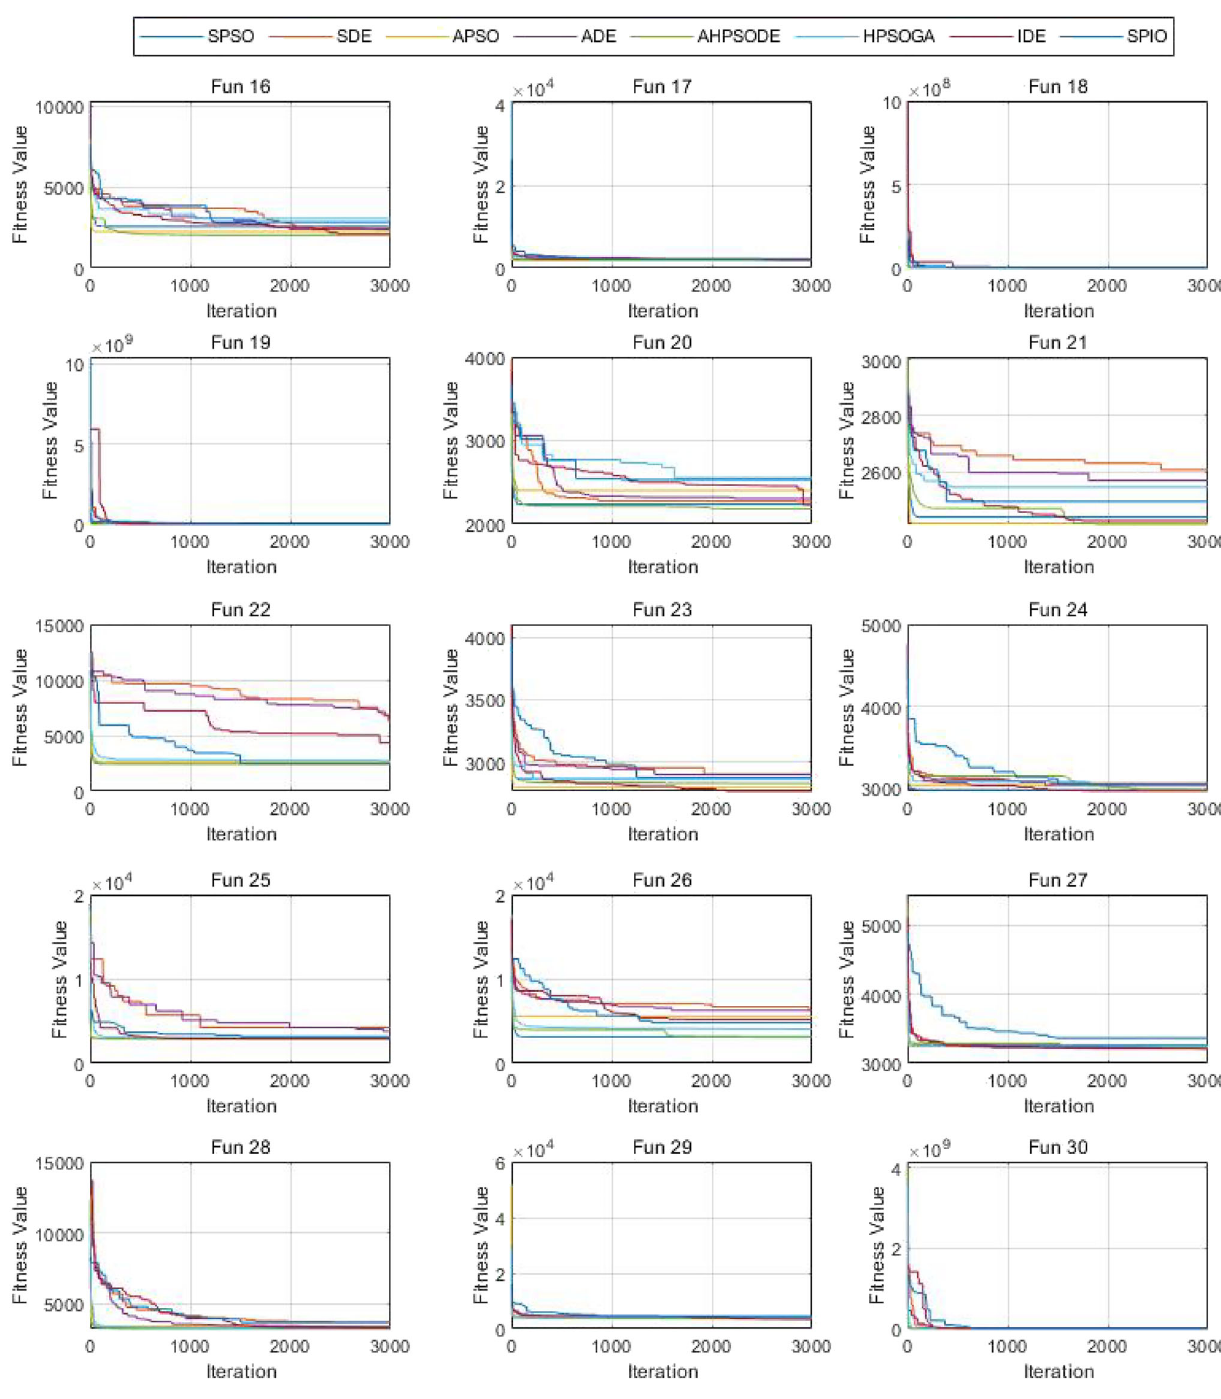
Fig. 24 Convergence curve of different algorithms on CEC 2017 at 30-D (Fun